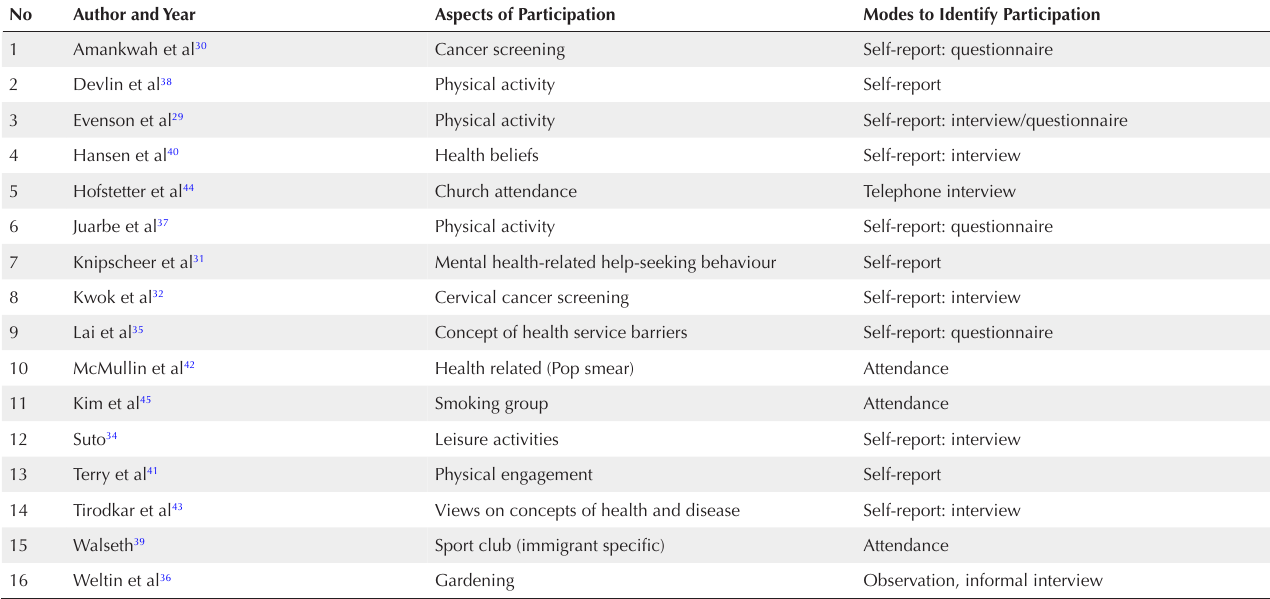
Table 3. Aspects of Participation/Non-participation in Each Study